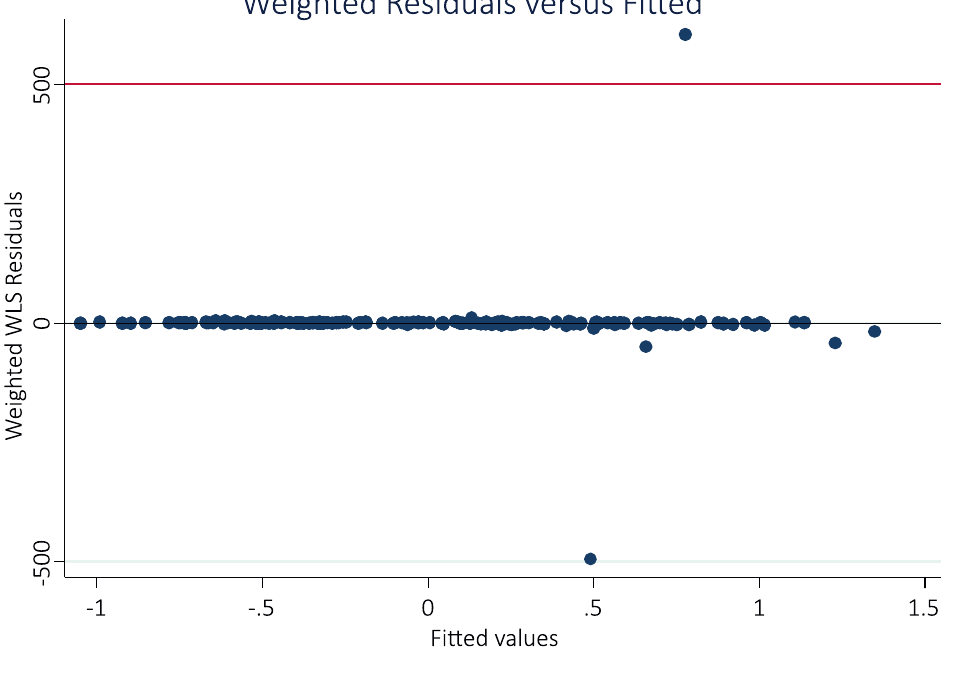
Figure 2. Test for heteroscedasticity of the estimated